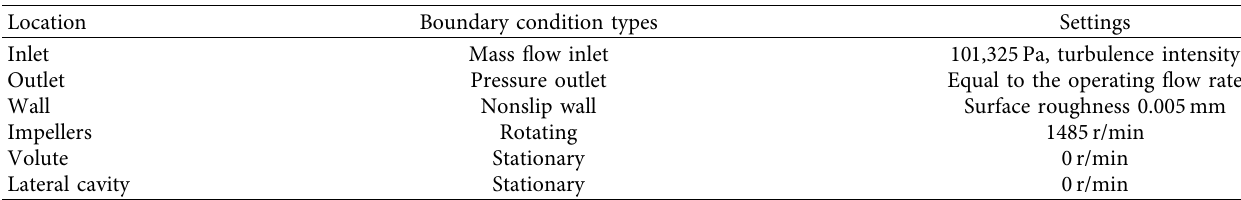
Table 3: Boundary conditions.